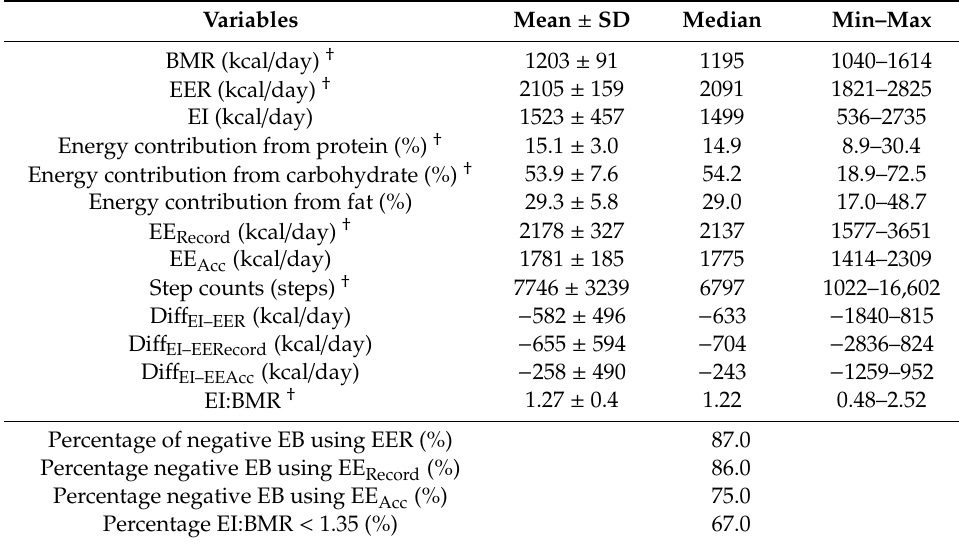
Table 2. Basal metabolic rate, estimated energy requirement, energy intake from dietary assessment and energy expenditure from physical activity assessments ( n =